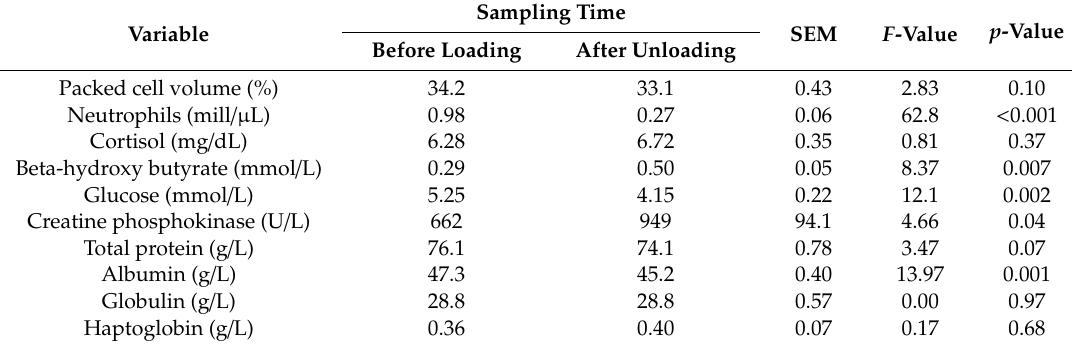
Table 3. Mean concentrations of blood variables of cattle before and after a journey by truck on the road and by sea, averaged across two di ff erent space allowances, Low 0.66 m 2 / head and High 0.86 m 2 / head.